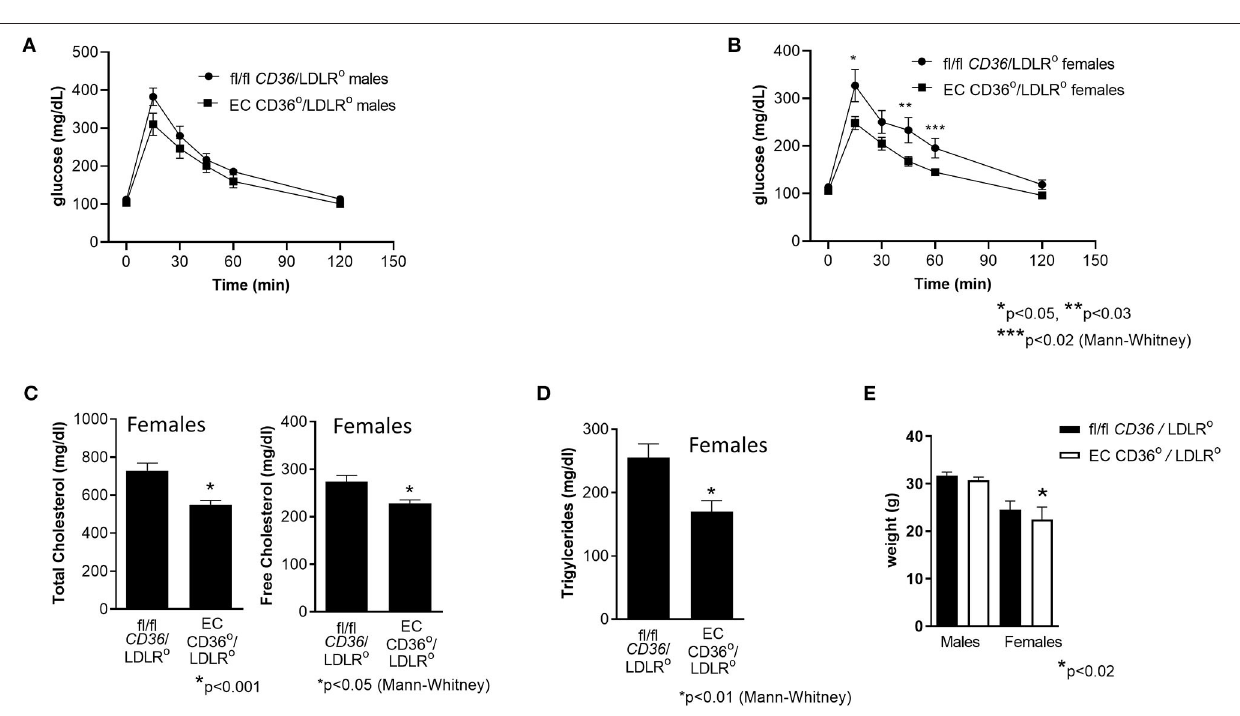
FIGURE 8 | Glucose tolerance testing, plasma cholesterol, and triacylglycerides of female EC CD36 ◦ /LDLR ◦ and fl/fl CD36 /LDLR ◦ mice at baseline and after 3 weeks high-fat high-cholesterol diet feeding. (A) At 6–7 weeks of age, prior to initiation of the high fat high cholesterol diet, there were no differences in glucose clearance between the groups. (B) After 3 weeks diet feeding, female EC CD36 ◦ /LDLR ◦ showed significant differences at 15, 45, and 60min time points. AUC was significantly different (fl/fl CD36 /LDLR ◦ : 23,896 ± 1,920; EC CD36 ◦ /LDLR ◦ : 18,409 ± 719, p < 0.02) (fl/fl CD36 /LDLR ◦ , n = 8; EC CD36 ◦ /LDLR ◦ , n = 10). (C) Plasma total and free cholesterol were significantly lower in EC CD36 ◦ /LDLR ◦ female mice after 3 weeks diet feeding (fl/fl CD36 /LDLR ◦ , n = 10; EC CD36 ◦ /LDLR ◦ , n = 13). (D) Plasma triacylglycerides were significantly lower in EC CD36 ◦ /LDLR ◦ female mice after 3 weeks diet feeding (fl/fl CD36 /LDLR ◦ , n = 10; EC CD36 ◦ /LDLR ◦ , n = 13). (E) There was no difference in weights at 8 weeks in males (fl/fl CD36 /LDLR ◦ : 31.68 ± 0.769g vs. EC CD36 ◦ /LDLR ◦ : 30.17 ± 0.826g) or females (fl/fl CD36 /LDLR ◦ : 24.44 ± 0.403g vs. EC CD36 ◦ /LDLR ◦ : 22.5 ±